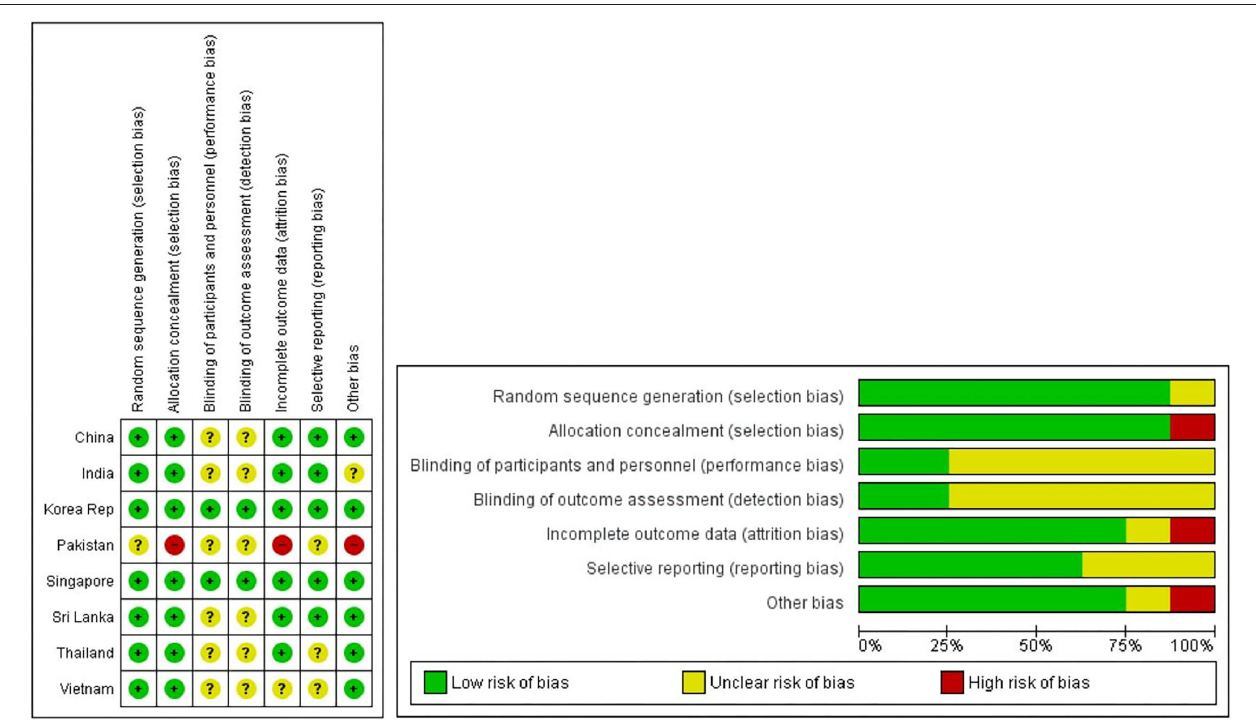
FIGURE 2 | Risk of bias graphs for selected studies with PSI. This figure shows review of authors’ judgements about each risk of bias item presented as percentages across all included studies. Random sequence generation were marked high due to selection